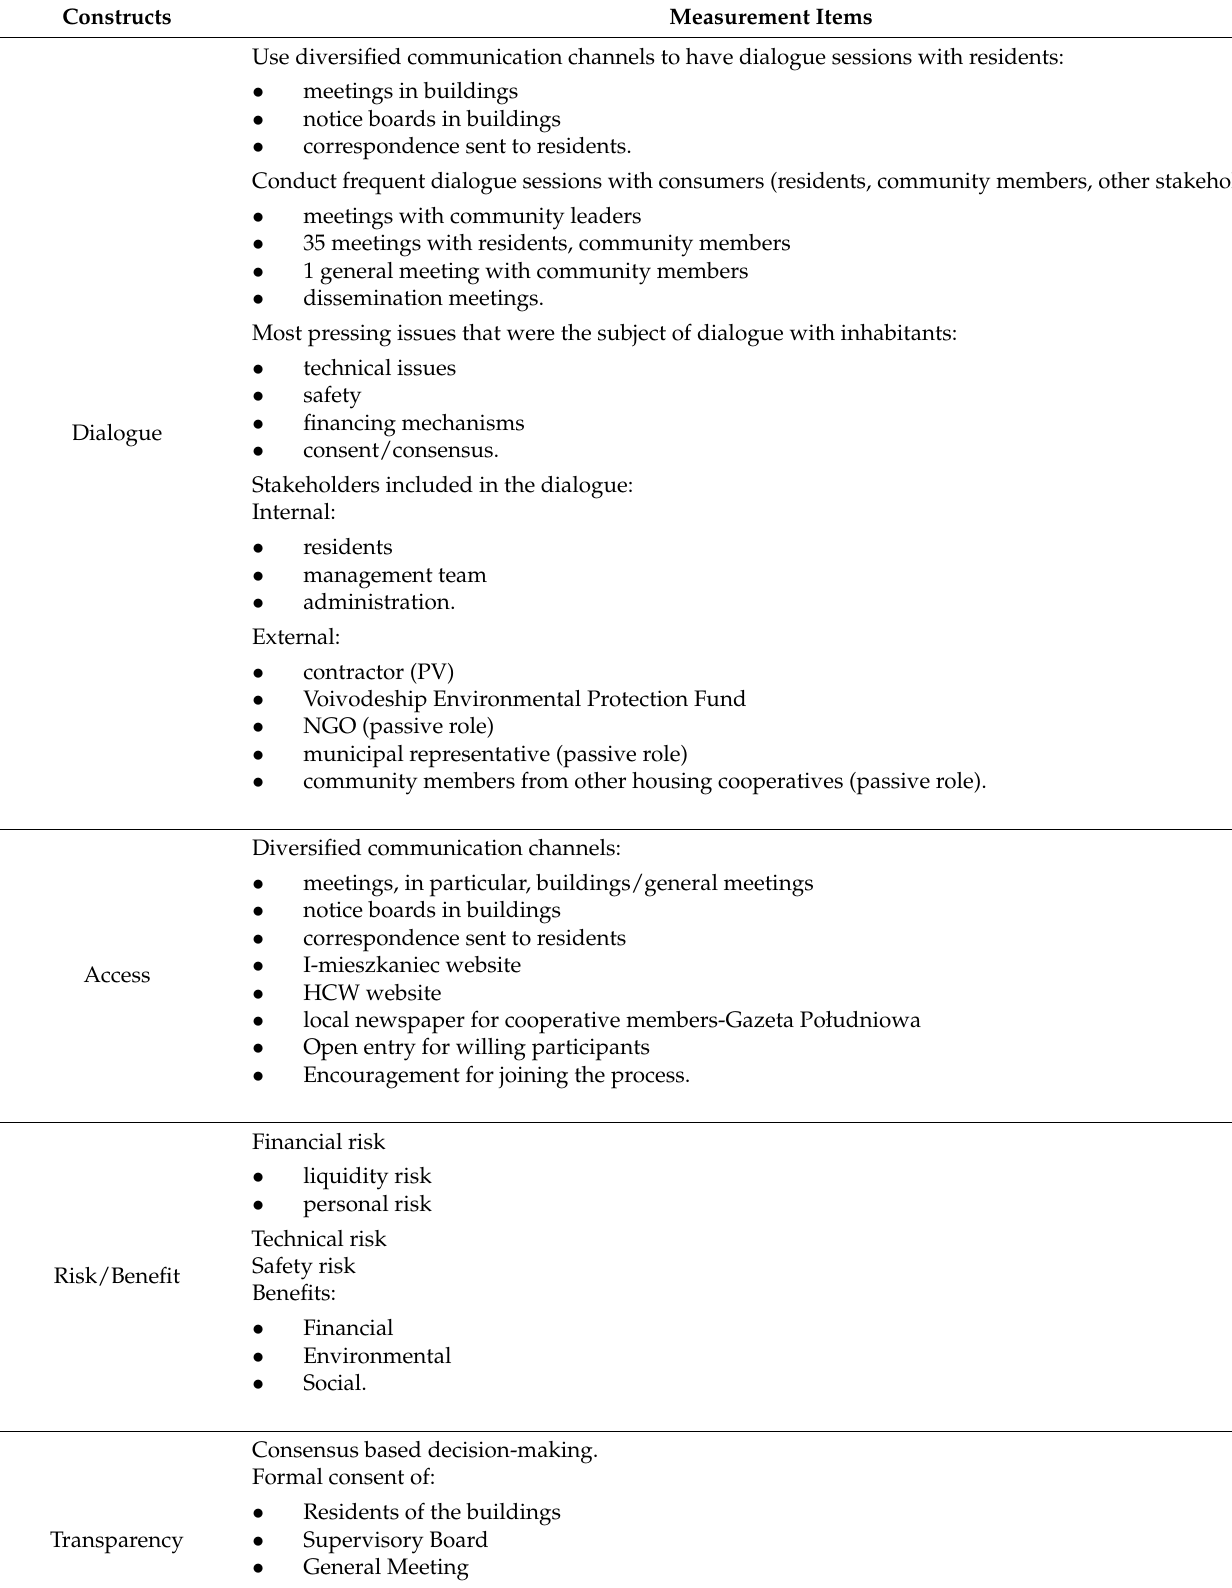
Table 5. Juxtaposition of the DART model elements with activities and actions implemented as part of the project.